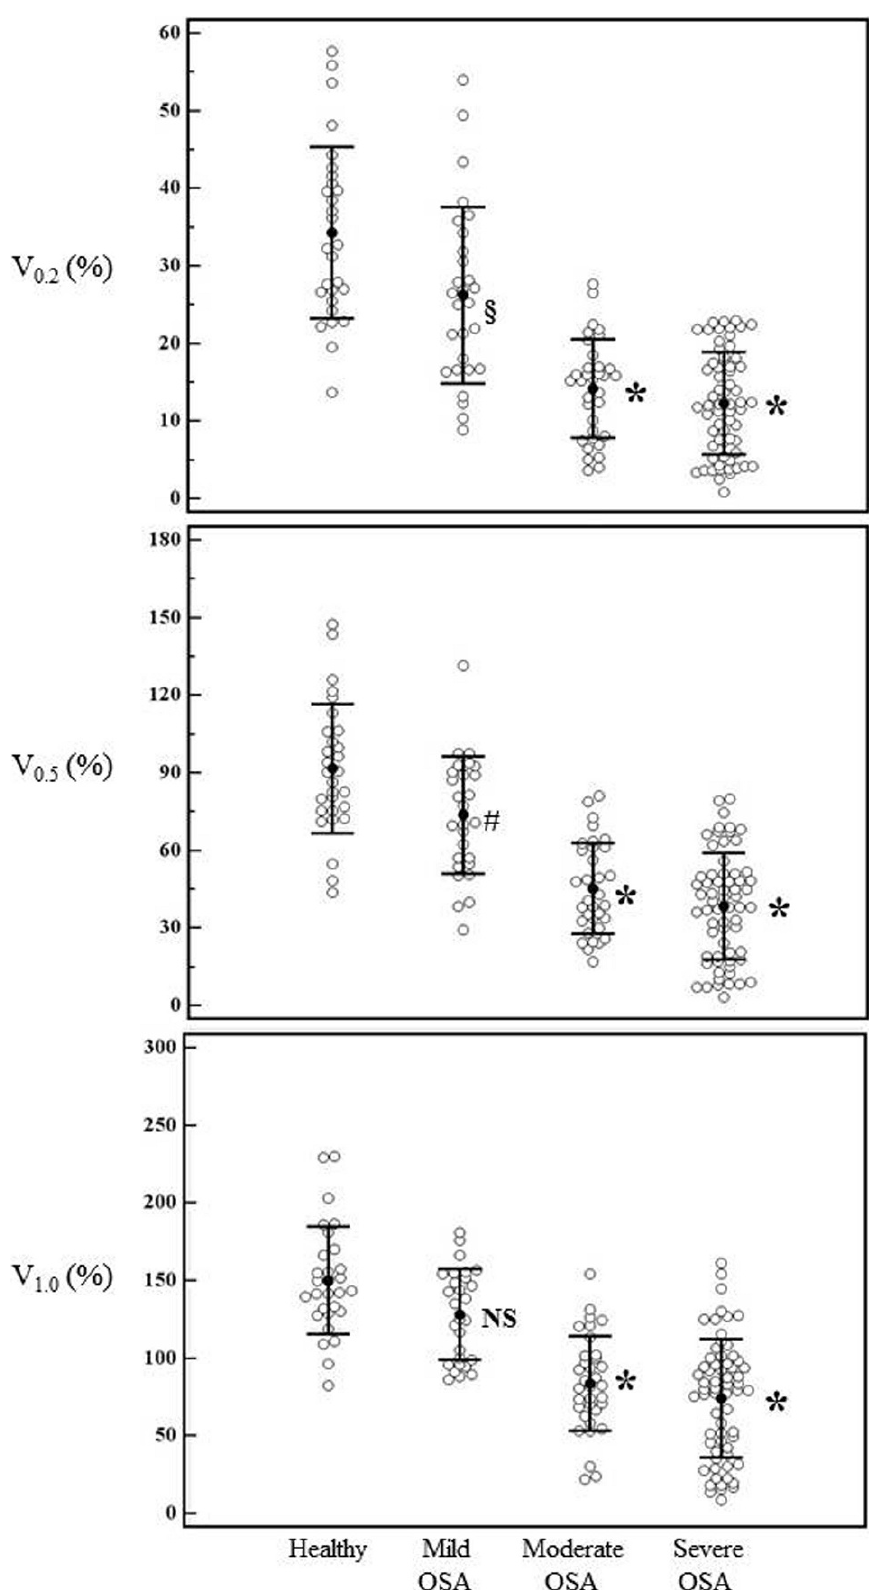
Figure 3 - Expiratory volumes of each subject at 0.2, 0.5, and 1.0 s expressed as the % of the mean expiratory volume of the three breaths preceding NEP application for healthy subjects and subjects from the 3 OSA severity groups. The means and SD are shown. NS: not significant, * p , 0.0001, 1 p , 0.003, # p , 0.01; healthy vs. OSA severity